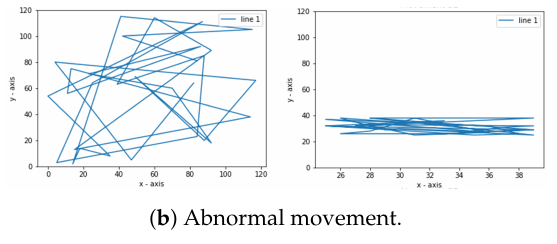
Figure 4. Movement simulation.